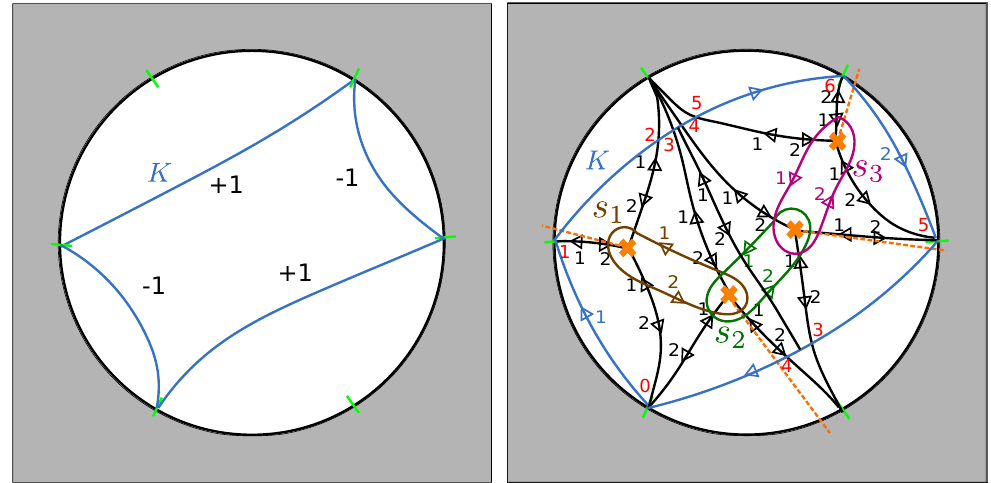
Figure 46 . Left: a lamination which corresponds to a line defect in the ( A 1 ; A 3 ) Argyres-Douglas theory. Here the irregular singularity is placed at in(cid:12)nity. The green markers represent the six marked points P i . Right: standard projection of a collection K of arcs corresponding to the lami- nation. The height pro(cid:12)le is speci(cid:12)ed in the same convention as (cid:12)gure 38. The open paths carrying (cid:0) 1 weight have a (cid:12)xed lift, as indicated in blue. We also show a choice of basis